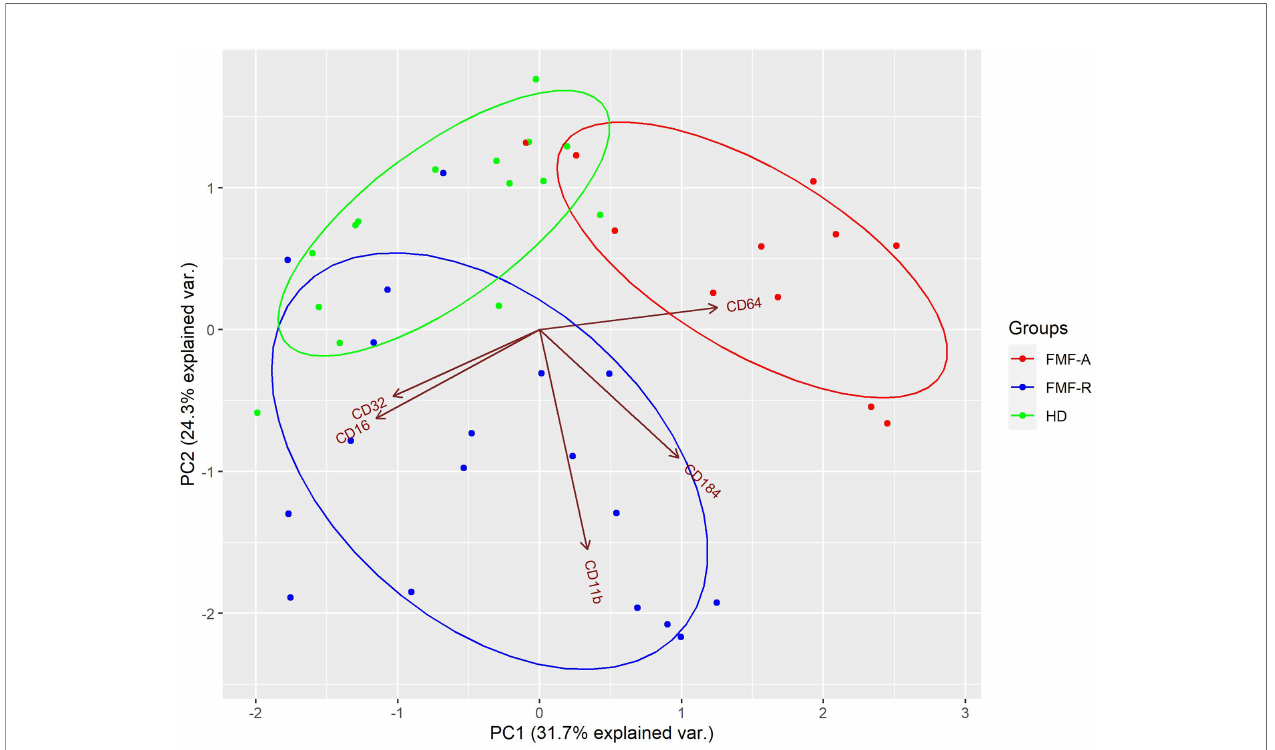
FIGURE 4 | Principal component analysis (PCA) of PMN from HD (green), FMF-R (blue), and FMF-A (red), characterized by combination of CD11b, CD16, CD32, CD64, and CXCR4 expression. Each dot on bi-plot graph represents a single patient/control. The model loadings are represented by vectors and indicate how each surface marker contributes to the cell variability in a speci fi c direction. Percentages represent variance captured by PC 1 and